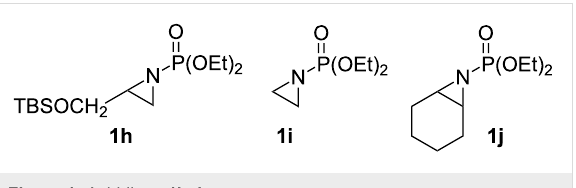
Figure 1: Aziridines 1h – j